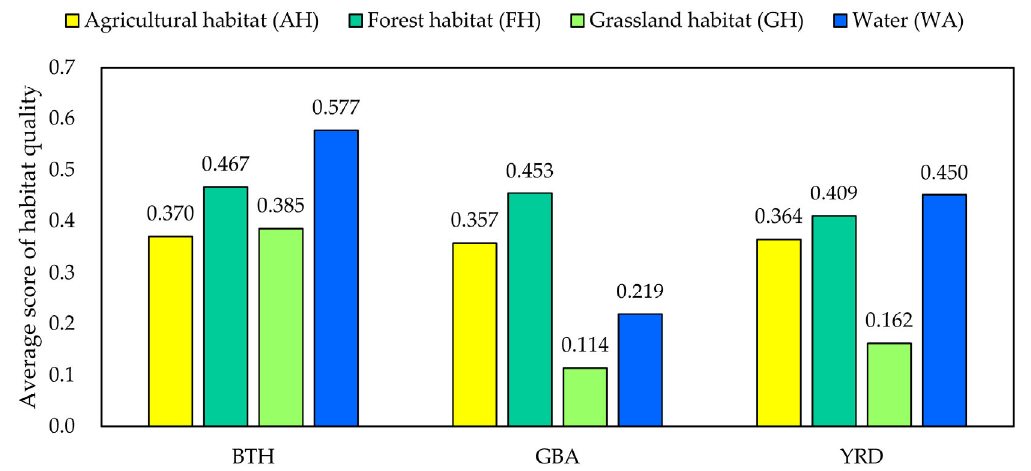
Figure 6. The scores of habitat quality for the four dominant land cover/use.